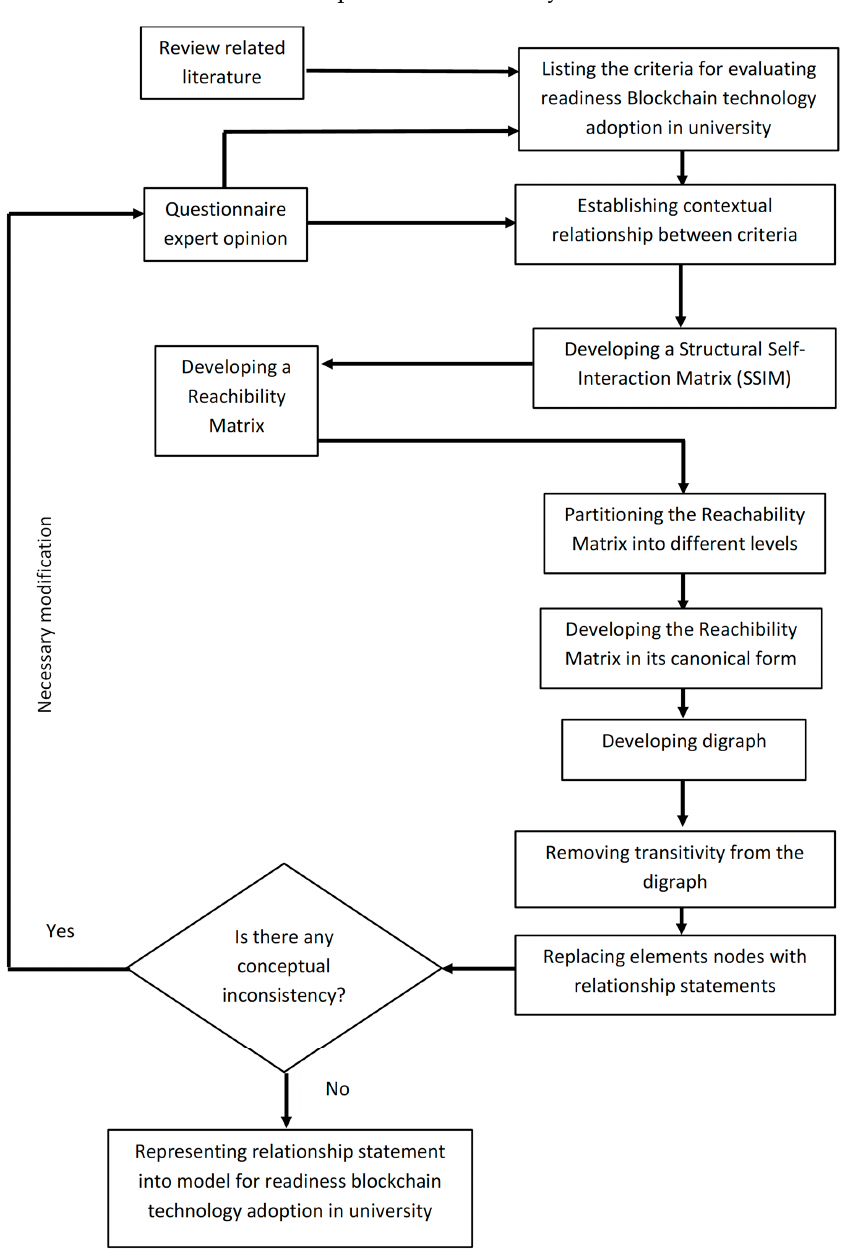
Figure 1. Proposed method to determine the main readiness factors for blockchain adoption in a university.